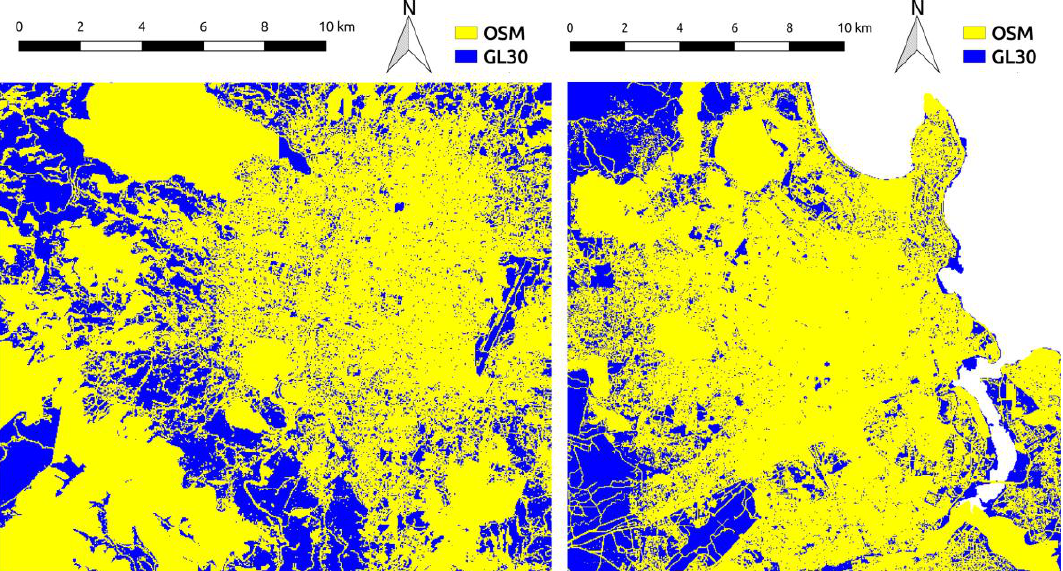
Figure 9. The source of the data of the enhanced GL30 maps for Kathmandu ( left ) and Dar es Salaam ( right ) study areas.